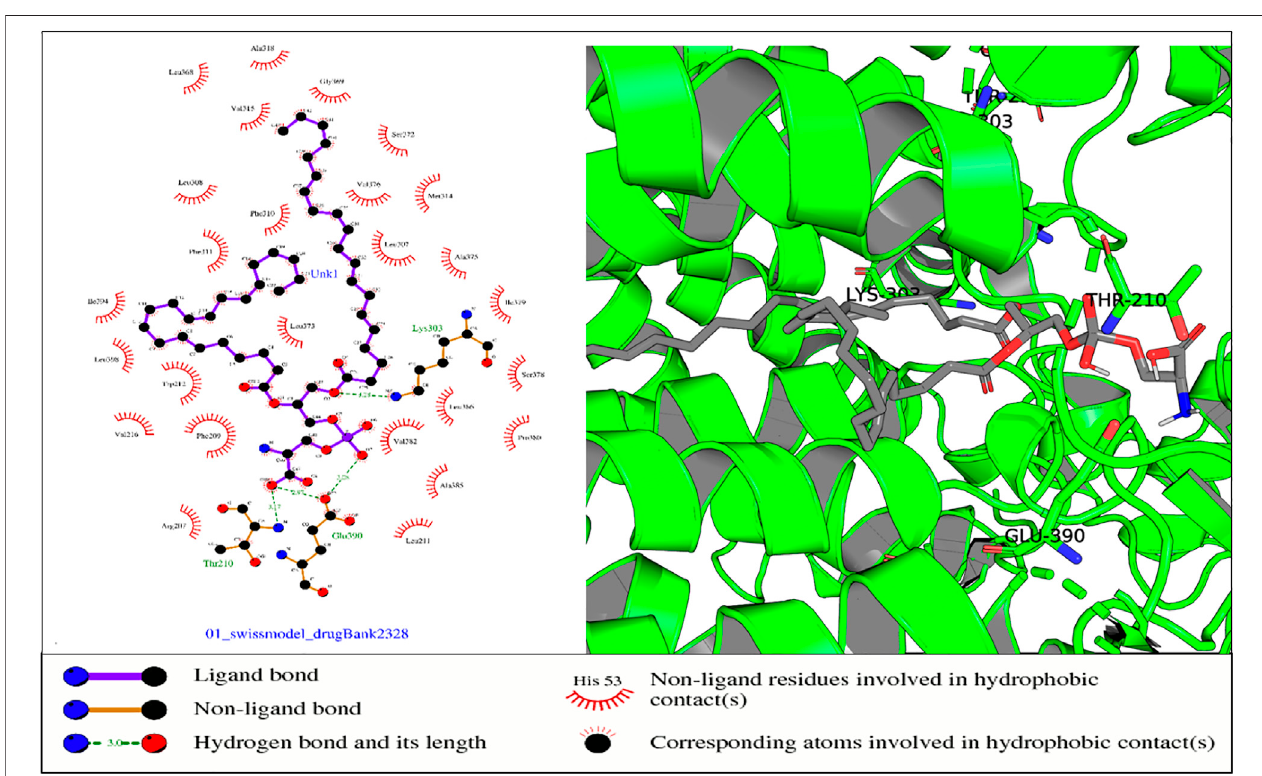
FIGURE 10 | In the aforementioned complex, receptor residues Thr-210 (NADP domain), Glu-390, and Lys-303 (TM5) form hydrogen bonds with ligand Drugbank 2328.